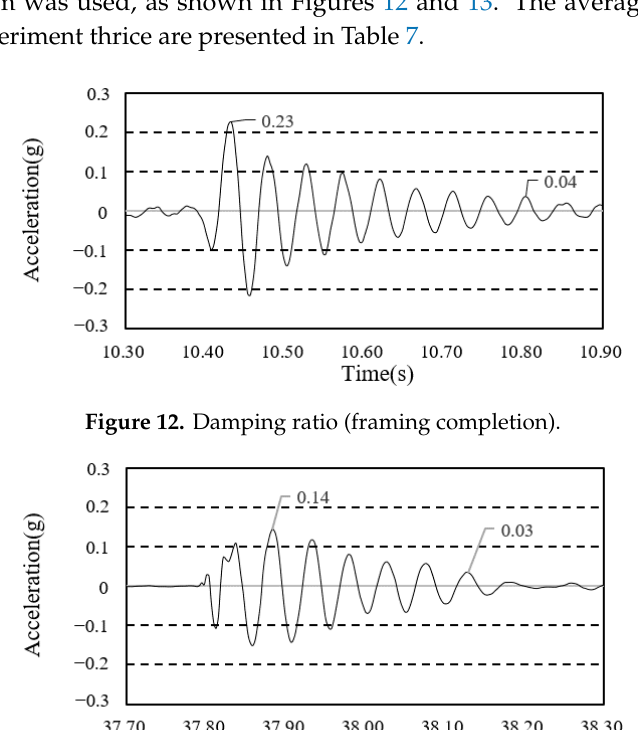
Figure 11. Power spectrum (cladding completion).